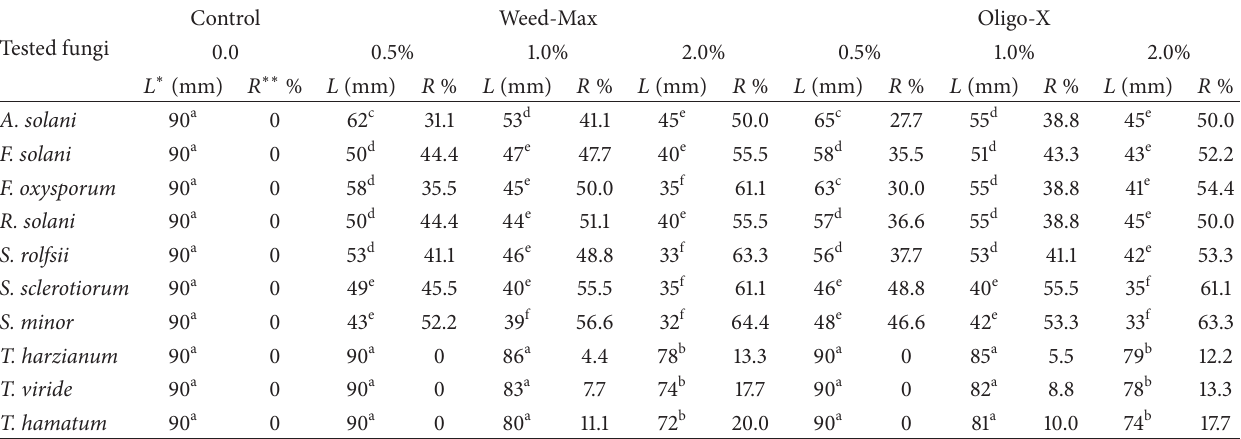
Table 1: Effect of algal compounds on the growth of some antagonistic and pathogenic soil-borne fungi in vitro .